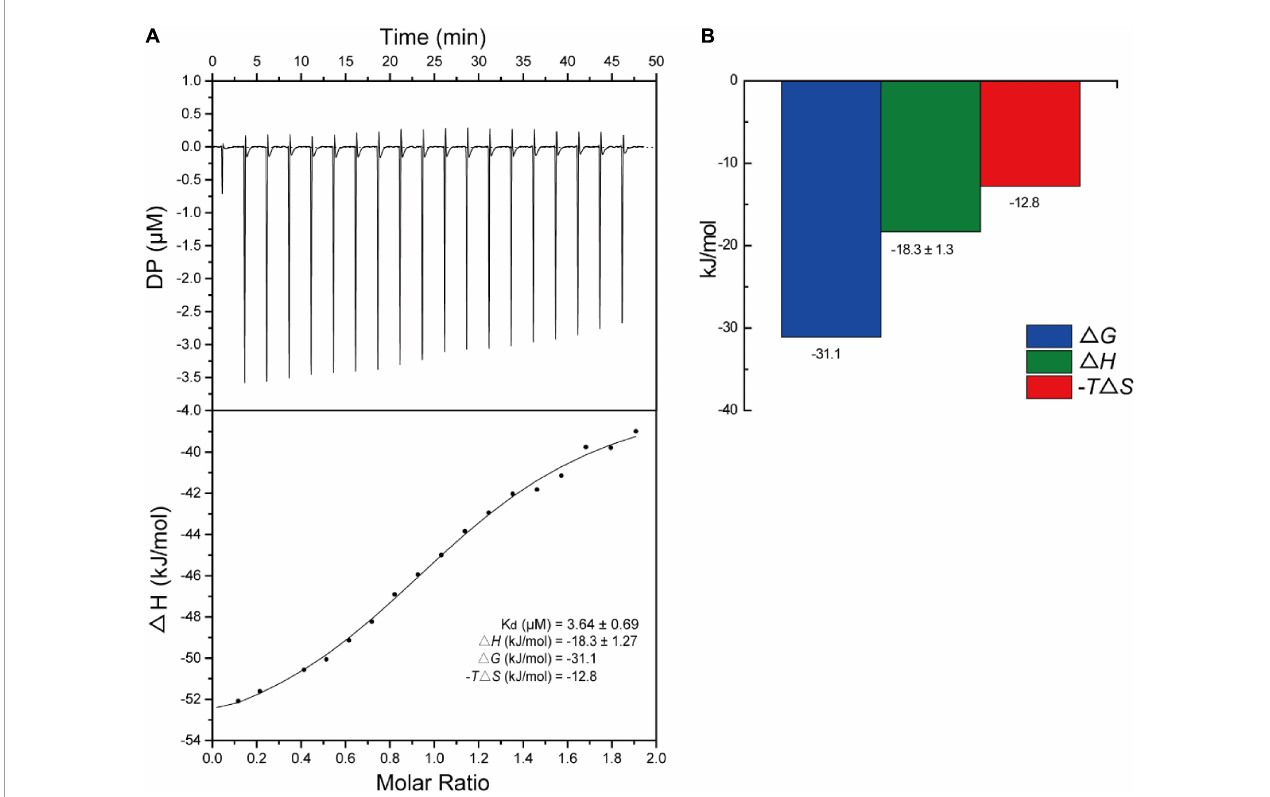
FIGURE7 Titration of S2303 to SaFtsZ. (A) The raw isothermal titration calorimetry (ITC) data of S2303 binding to SaFtsZ (top) and the integrated heat peaks against the molar ratio of S2303 (bottom). (B) Thermodynamics properties of the S2303 and SaFtsZ interaction characterized by ITC. DP: a measured power differential between the reference and sample cells to maintain a zero temperature between them. The experiment was repeated in